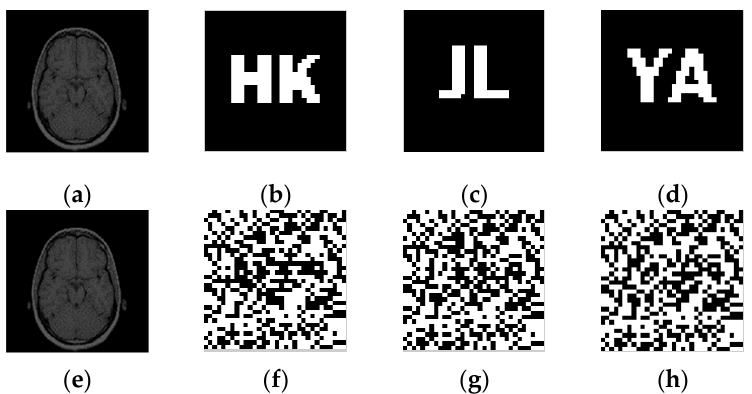
Figure 13. Watermarked medical image and encrypted watermarks: ( a ) Original medical image; ( b ) Original binary watermark 1; ( c ) Original binary watermark 2; ( d ) Original binary watermark 3; ( e ) watermarked medical image; ( f ) encrypted watermark 1; ( g ) encrypted watermark 2; ( h ) encrypted watermark 3.